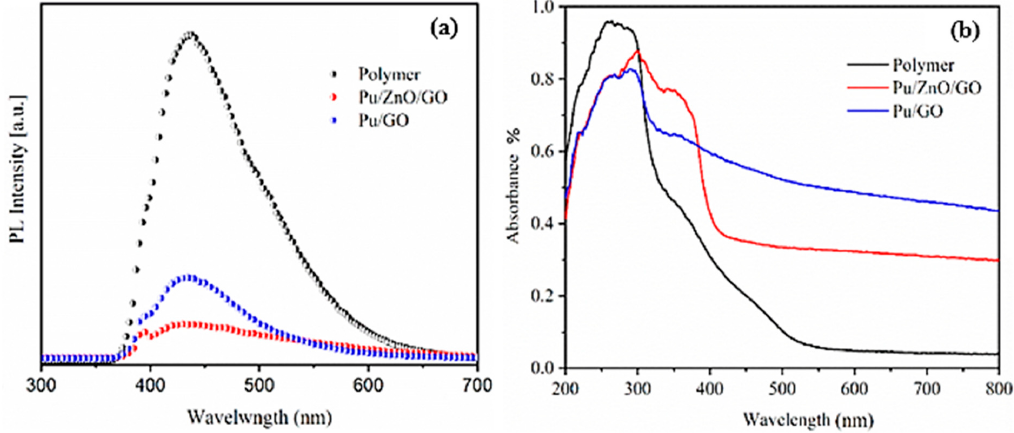
Figure 8. ( a ) UV − vis spectra for neat PUF, PUF/GO, ( b ) PUF/GO/ZnO nanocomposite.